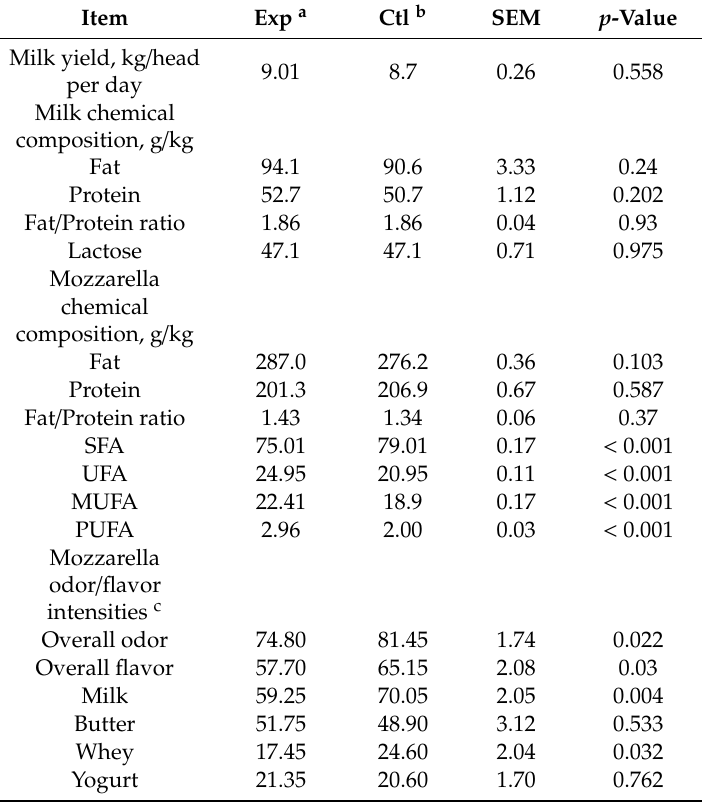
Table 2. Milk and mozzarella characteristics (least square means), as a ff ected by fresh sorghum dietary inclusion (data from Uzun et al., 2018 [26]). Item Exp a Ctl b SEM p